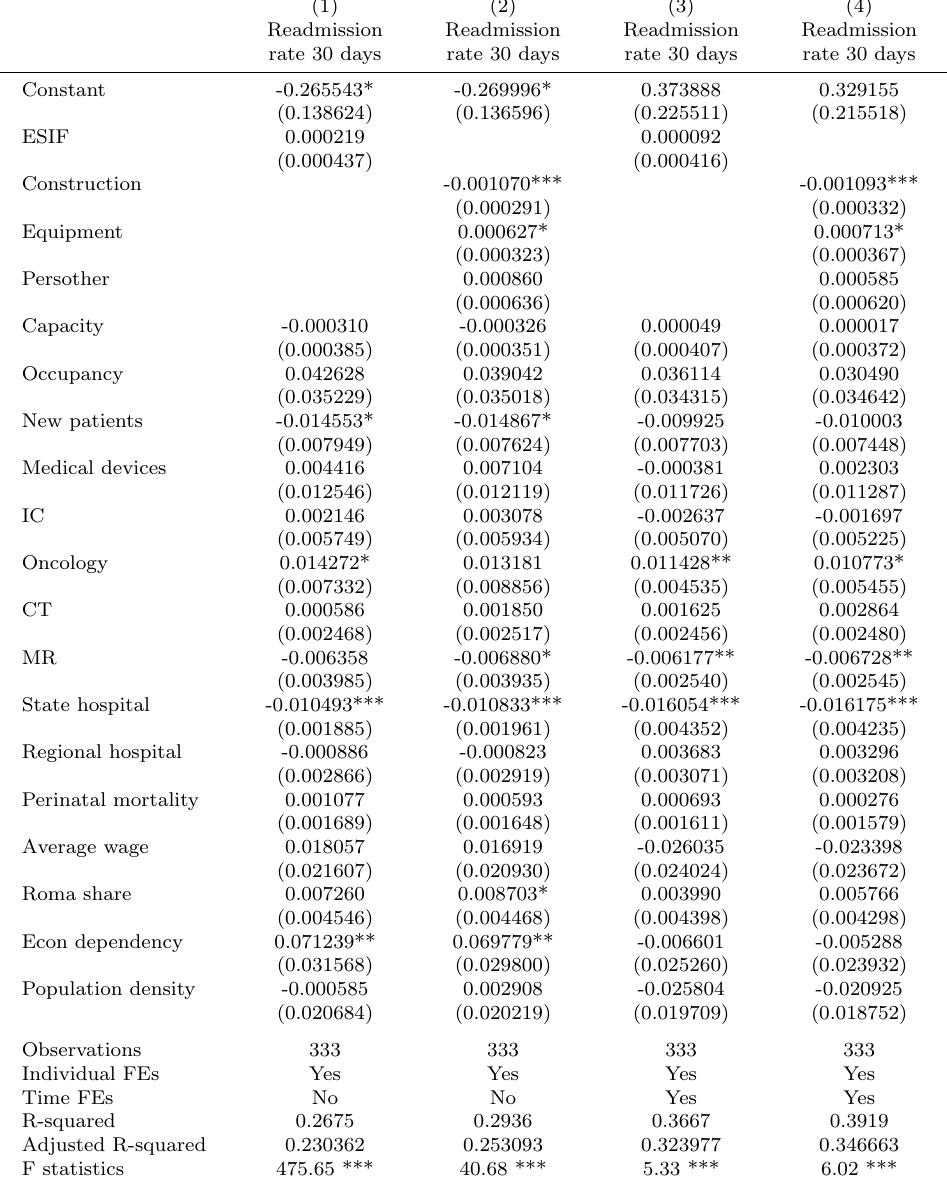
Table A.1: Contemporaneous effect of cumulative ESIF on the readmission rate – full